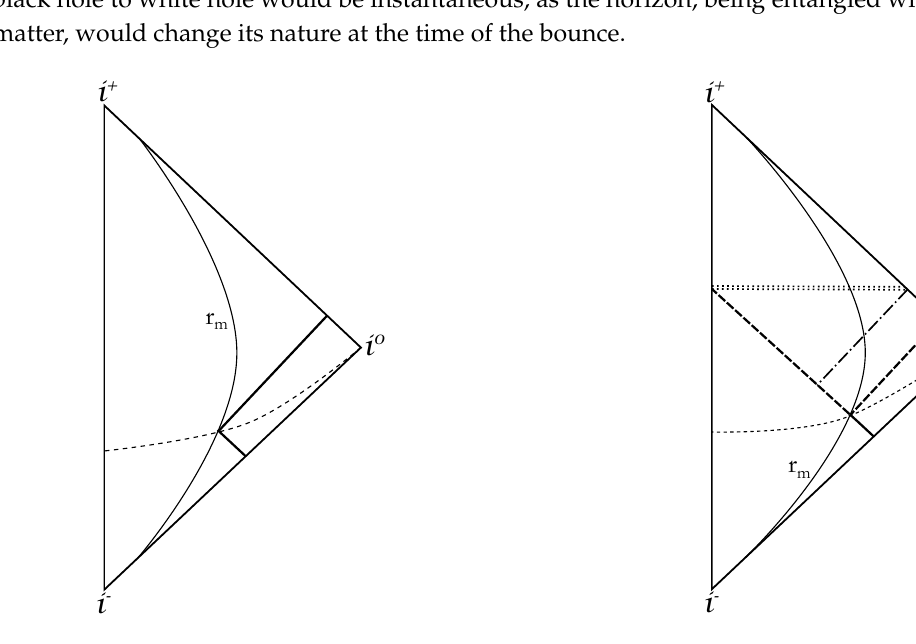
Figure 4. Penrose diagrams of a collapsing Vaidya null shell with a massless mirror ( left panel ) and a semi-reflective mirror ( right panel ). The trajectory of the static mirror is given by the fixed value of the radius r = r m > 2 M (solid thin line). The dotted line represents a line of constant t . Left panel : The ingoing wavepacket (thick solid line) reaches the mirror and bounces back to infinity. Right panel : The ingoing wavepacket reaches the semi-reflective mirror. The wave function is split into two entangled parts, one ingoing and one outgoing (dashed lines). As a consequence, when the ingoing part crosses the Schwarzschild radius, an ‘entangled’ horizon (dot-dashed line) and eventually an ‘entangled’ singularity (double dotted line) form. If a detector is placed on the trajectory of the outgoing part of the wavepacket the whole system will collapse to either the diagram in the left panel